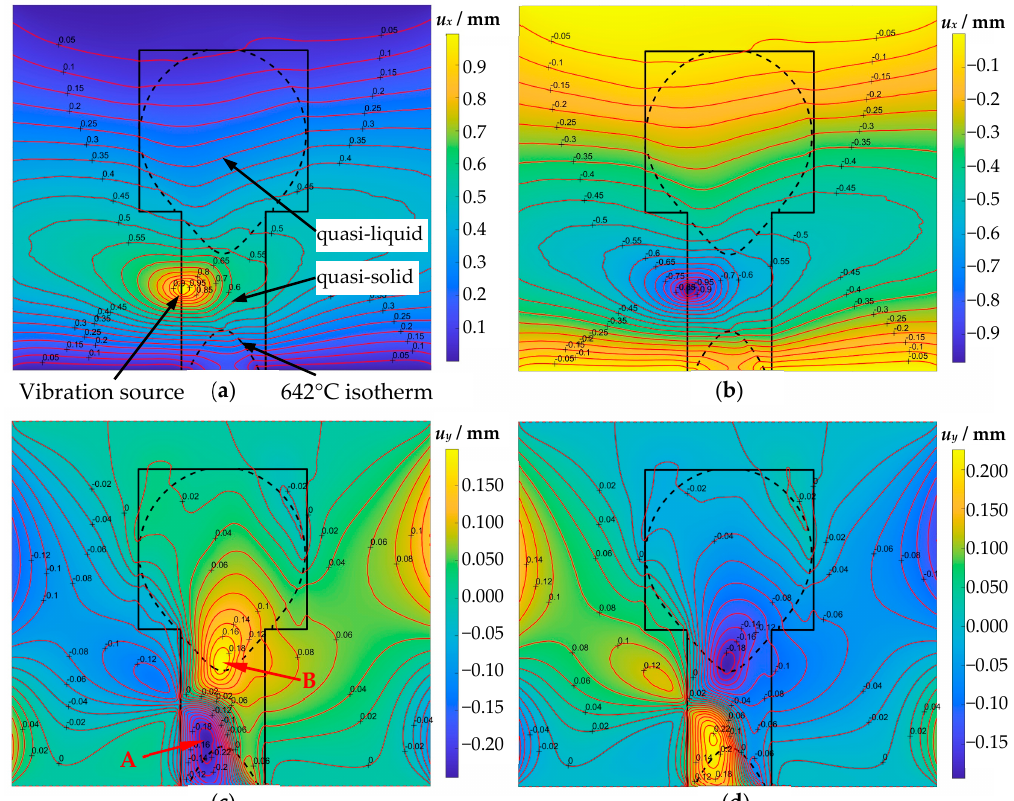
Figure 7. The displacement at the time to peak in the 30% solid fraction of the feeding channel: ( a ) u x at 220 ms; ( b ) u x at 240 ms; ( c ) u y at 220 ms; ( d ) u y at 240 ms.